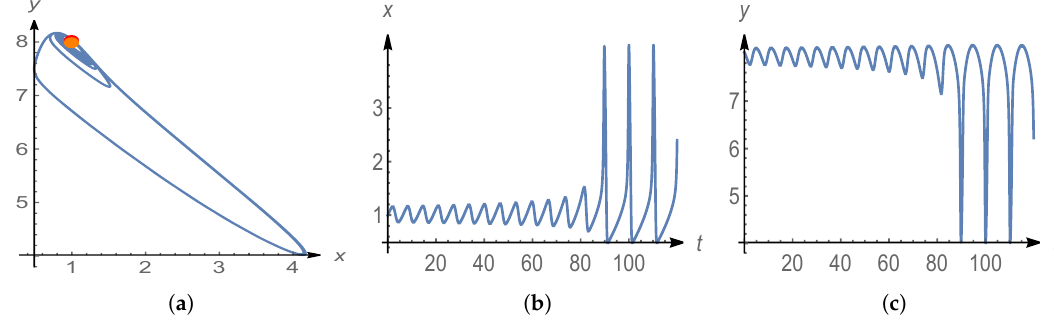
Figure 3. Model 1 with one stable limit cycle. The trajectory is going outward approaching the limit cycle. The distance of the initial point from the singular point is d =